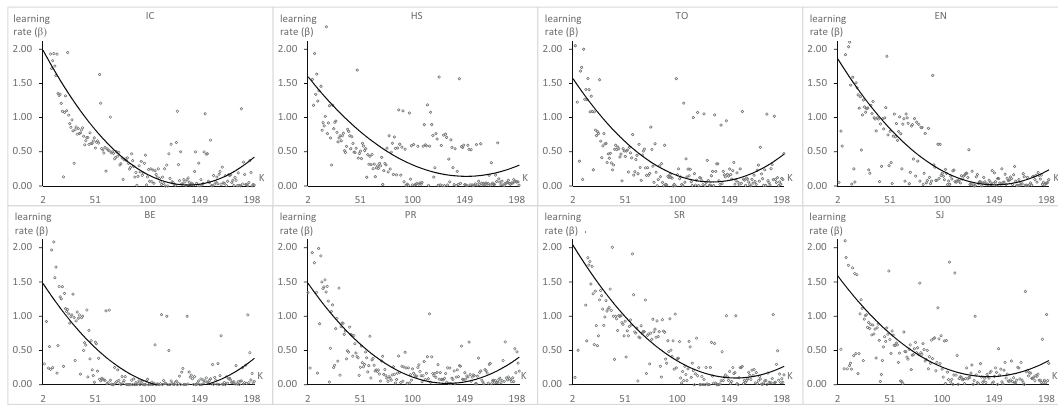
Figure 8. Optimal value of the learning rate β for each value of K